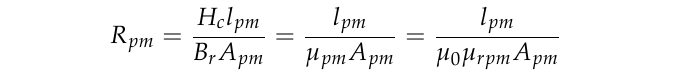
Figure 6. The magnetic Thévenin equivalent circuit of the permanent magnet in terms of its parameters.